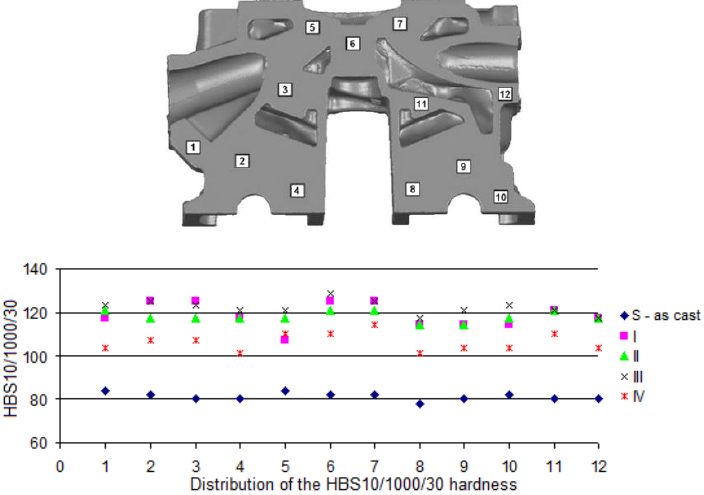
Figure 10. Areas of hardness measurement on the casting of the cylinder head—cross-section no. 3.